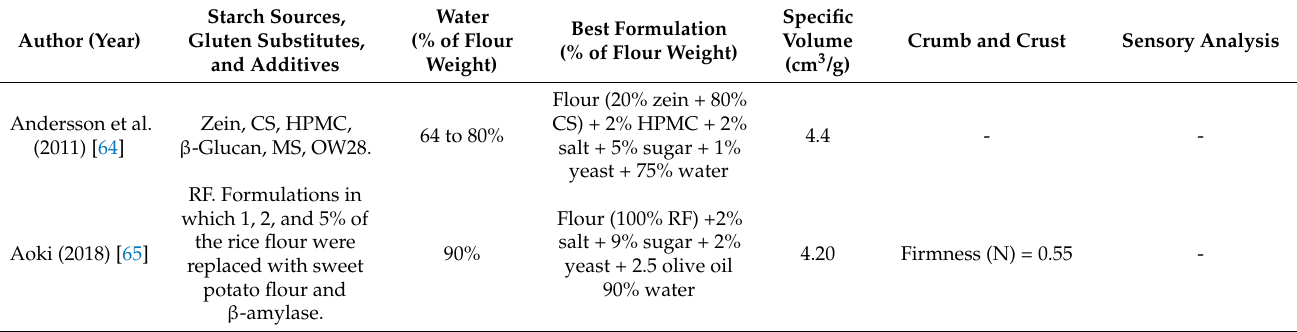
Table 1. Extraction table containing references, starch sources, gluten substitutes, additives, water, specific volume, crumb and crust characteristics, and sensory analysis of gluten-free bread with specific volume above 3.5 cm 3 /g. Starch Sources, Author (Year) Gluten Substitutes, Sensory